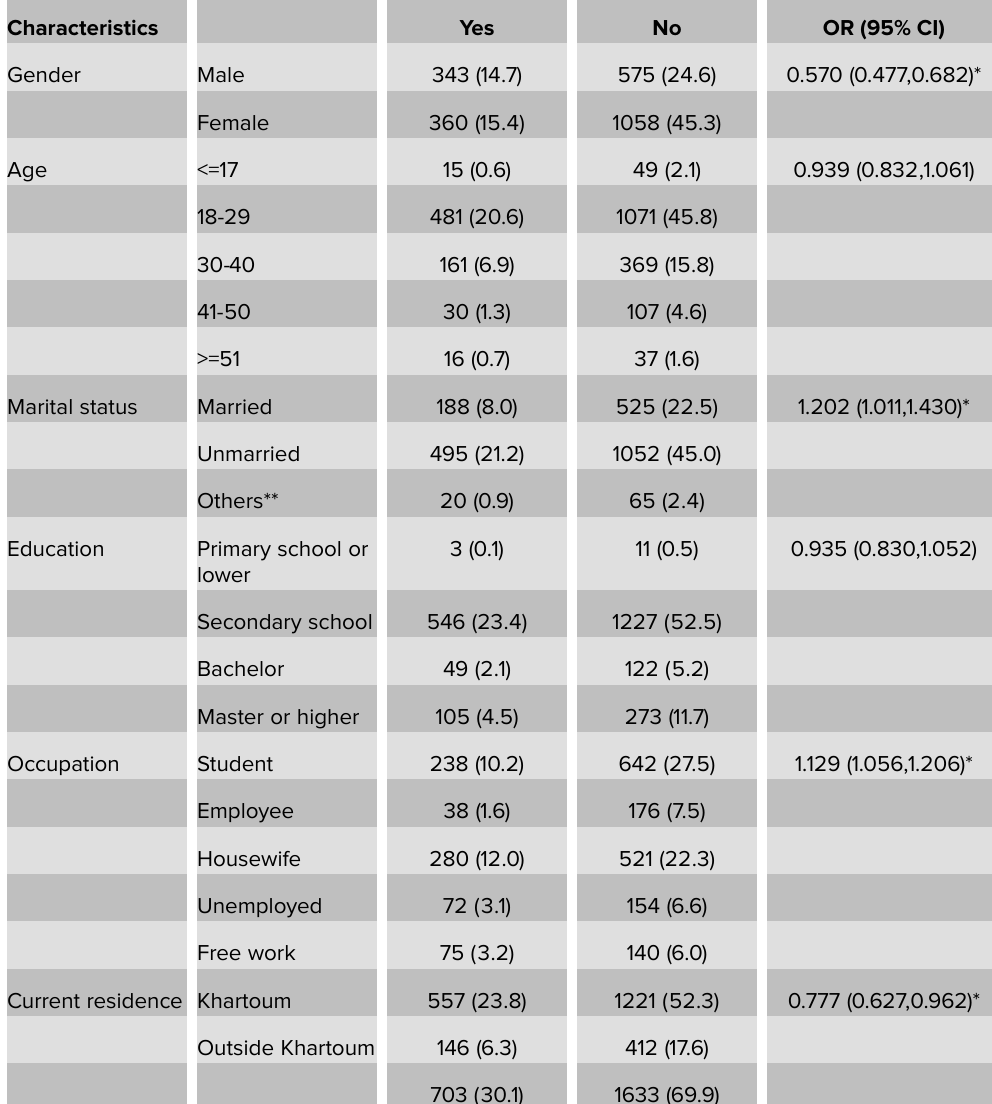
TABLE 6: Practices towards COVID-19 by demographic variables, (In the last few days, have you gone to any crowded area?)